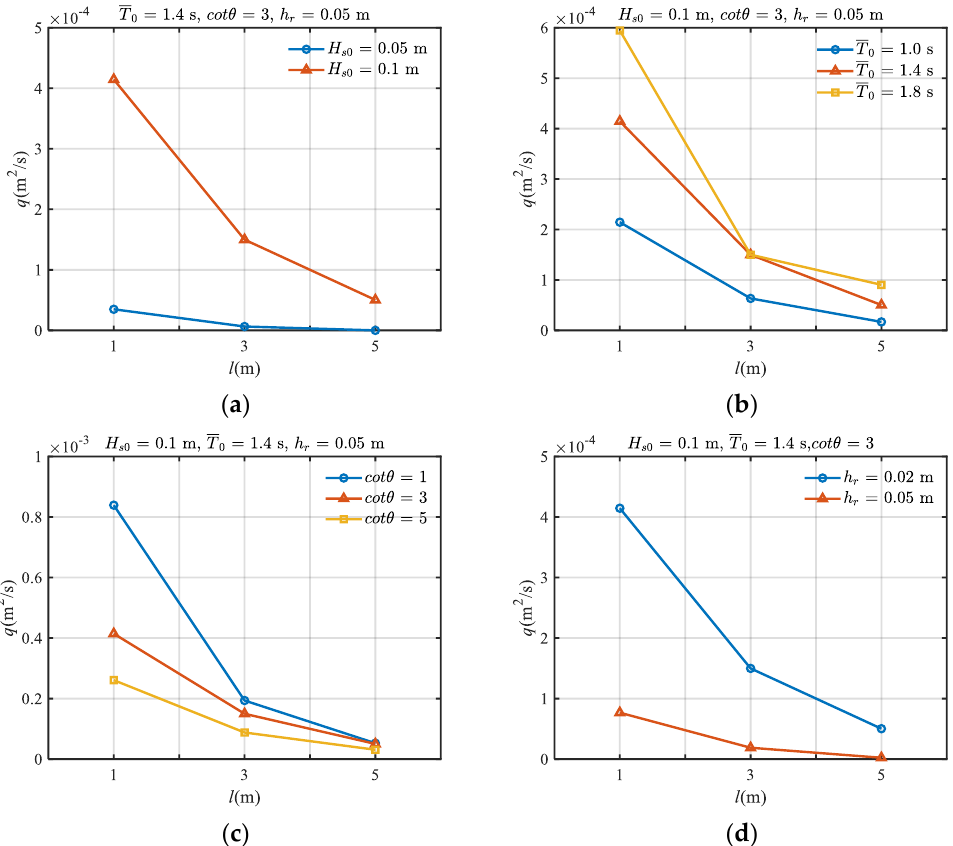
Figure 21. Irregular mean wave overtopping discharge over the vertical seawall for different